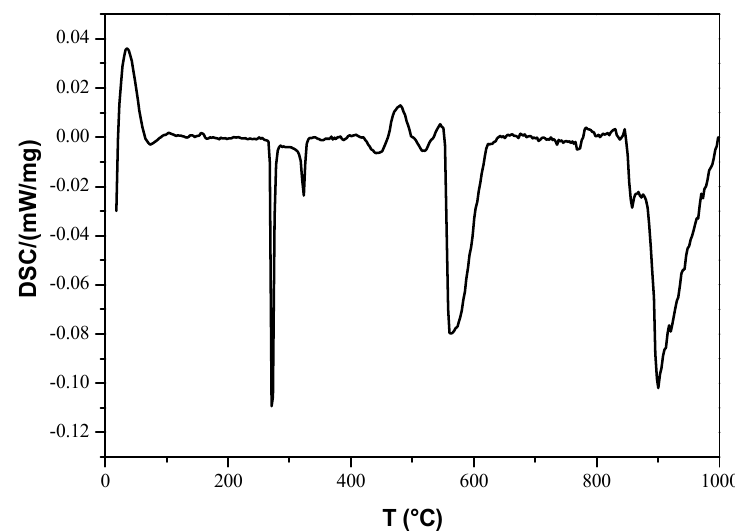
Figure 1. The DSC curve of the Bi 12 ZnO 20 nanoparticles.